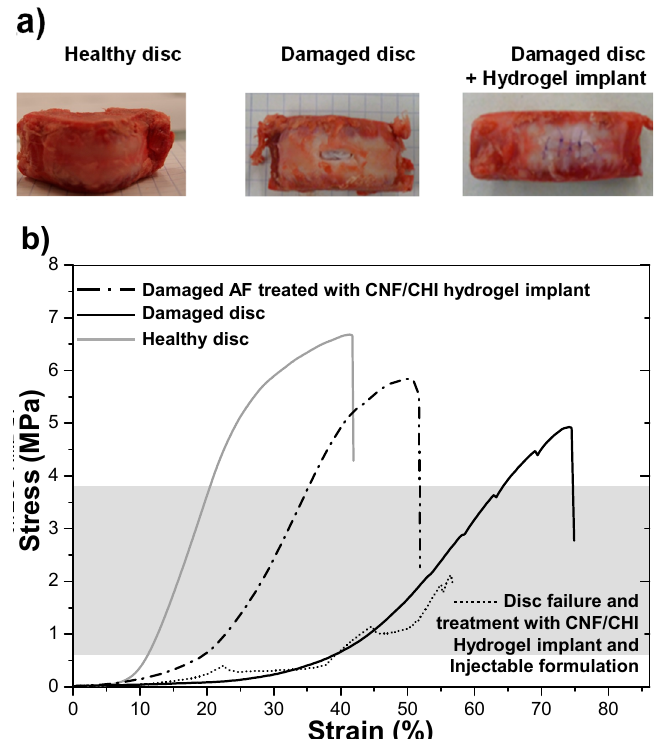
Figure 8. ( a ) Examples of healthy, damaged, and hydrogel-implanted discs for which spinal motion segments, consisting of two vertebral endplates and the disc joining them together, biomechanical testing were performed. ( b ) Compression stress–strain curves of healthy, damaged, and hydrogel-implanted intervertebral disc. For the latter, the intervertebral disc annulus fibrosus was repaired with a 3% CHI/0.4% CNF composite hydrogel patch. Grey shadow: Physiological loading range.